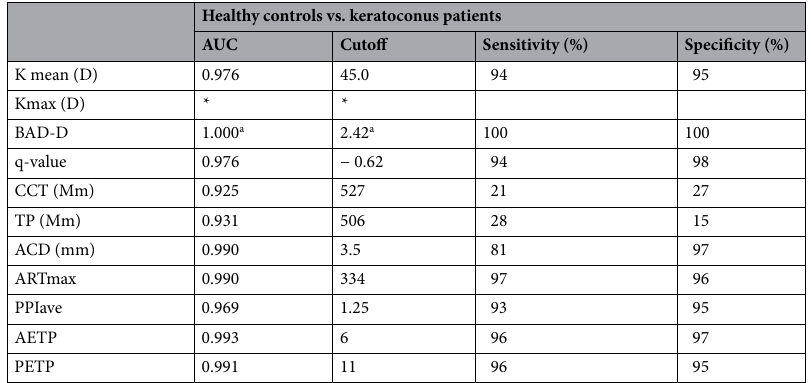
Table 4. Area under the receiving operator curve for topographical parameters in a comparison between healthy controls and pediatric keratoconus patients. Kmean mean keratometry, Kmax maximum keratometry, Astig astigmatism, CCT central corneal thickness, TP thinnest pachymetry, ACD anterior chamber depth, BAD-D Belin/Ambrosio enhanced ectasia display, ARTmax Ambrosio’s relational thickness maximum, PPIave average pachymetric progression index, AETP anterior elevation at the thinnest point, PETP posterior elevation at the thinnest point, PE maximum posterior elevation. *Kmax > 47.1 predicts the data perfectly and was used as a diagnostic criterion for keratoconus. a BAD-D > 2.42 predicts the data perfectly.